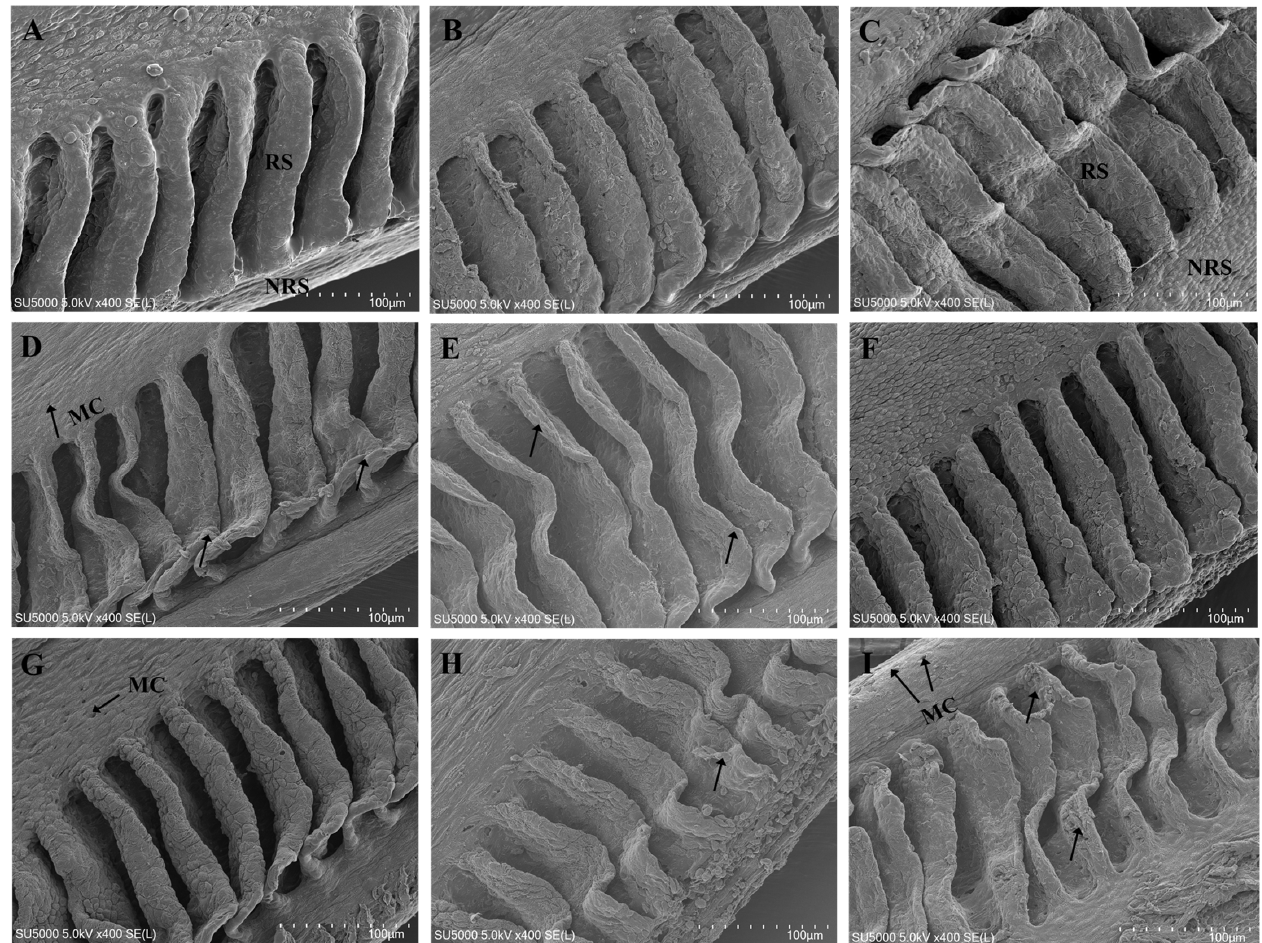
Figure 6. Representative SEM micrographs showed changes in the gill structure of pearl gentian grouper following 0, 48, and 72 h of exposure to various concentrations of nitrite: ( A ) 0 mg/L-0 h, ( B ) 0 mg/L-48 h, ( C ) 5 mg/L-48 h, ( D ) 10 mg/L-48 h, ( E ) 20 mg/L-48 h, ( F ) 0 mg/L-72 h, ( G ) 5 mg/L-72 h, ( H ) 10 mg/L-72 h, and ( I ) 20 mg/L-72 h. Bars = 100 µm. Non-respiratory surface (NRS), respiratory surface (RS), mucous cell (MC), and gill lamella disorder ( ↑ ).